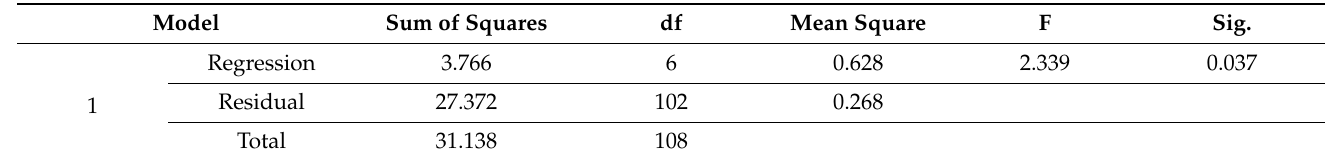
Table 12. ANOVA misidentification and HIS